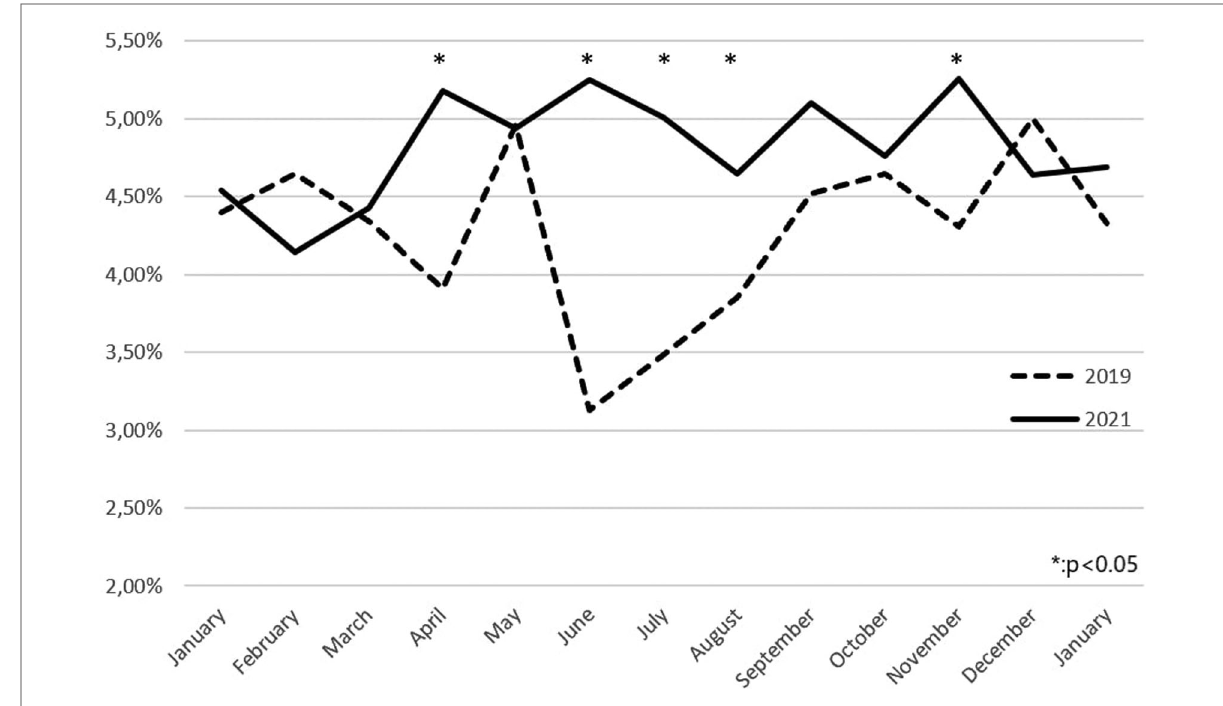
FIGURE 1 Comparison between emergency department admissions for headache in 2019 and